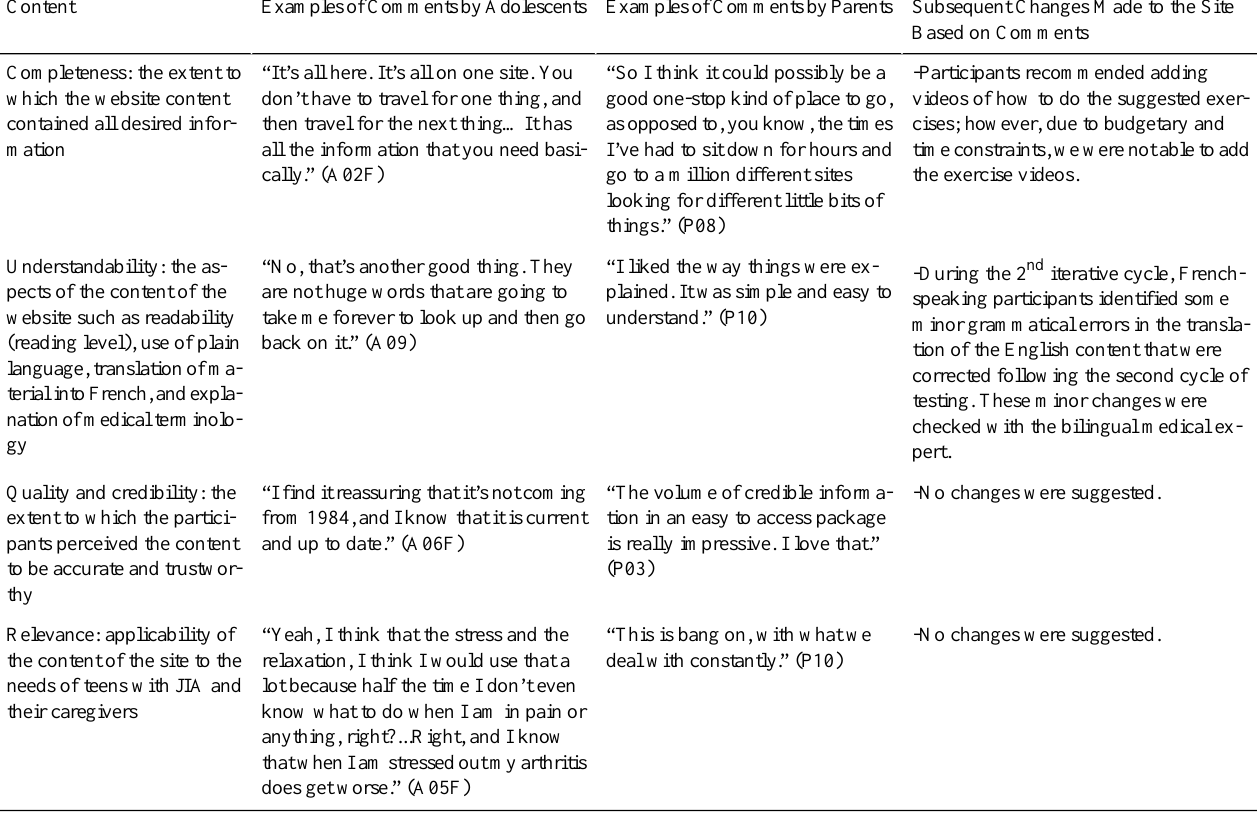
CommentsExamples of Comments by ParentsExamples of Comments by AdolescentsContent